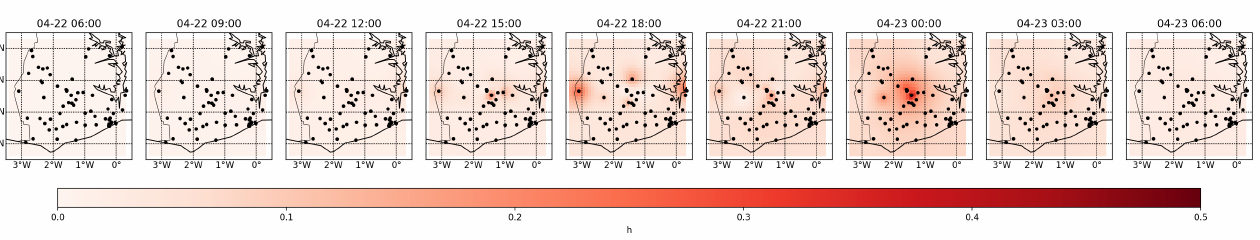
Figure 15. Standard deviation of the mappings in the LOOV experiment. The positions of the stations are marked by black dots.